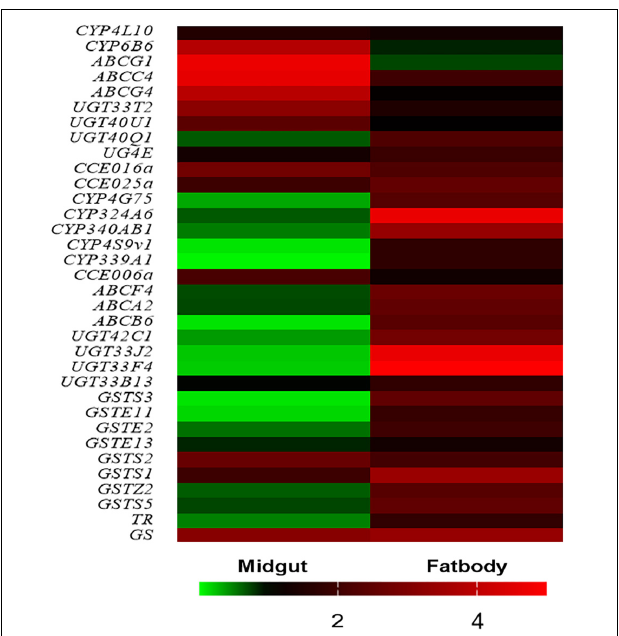
FIGURE 4 | Biological (independent) qRT-PCR validation of the RNA-Seq data. The first 11 genes are highly expressed in the midgut when exposure to tomatine (TOM), and the latter 23 genes are highly expressed in fat bodies when exposure to TOM. The bar represents the scale of the expression levels of TOM treatment/Control. The red, black, and green bar indicates mRNA expression levels of TOM treatment are higher, similar or lower than the control groups, respectively. The detailed fold change and p value were shown in Supplementary Table S2